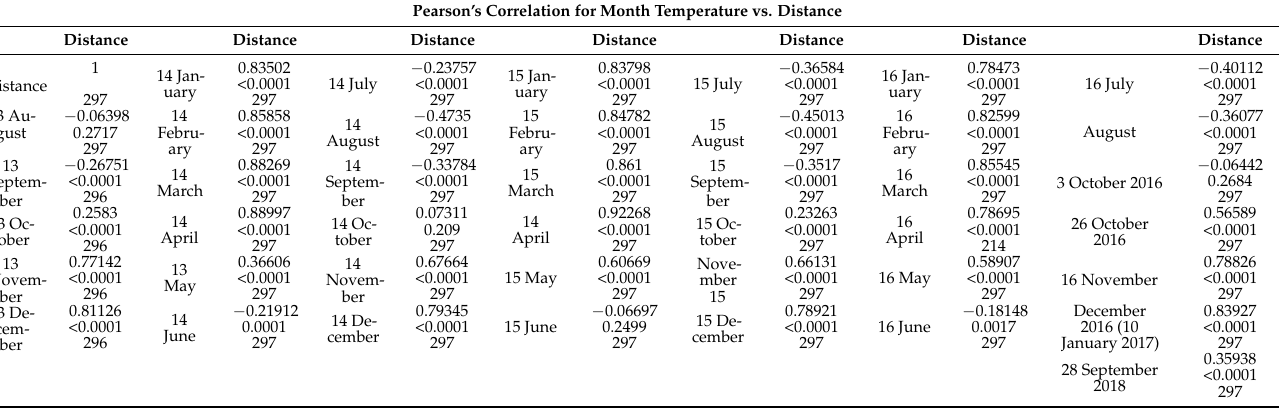
Table 1. Pearson’s correlations analysis between different months and increment of depth/distance at Suvilahti, Ketunkatu in the city of Vaasa. The first row shows Pearson’s correlation results, the second row shows statistical significance, and the third row shows the number of samples in each analysis. Pearson’s Correlation for Month Temperature vs. Distance